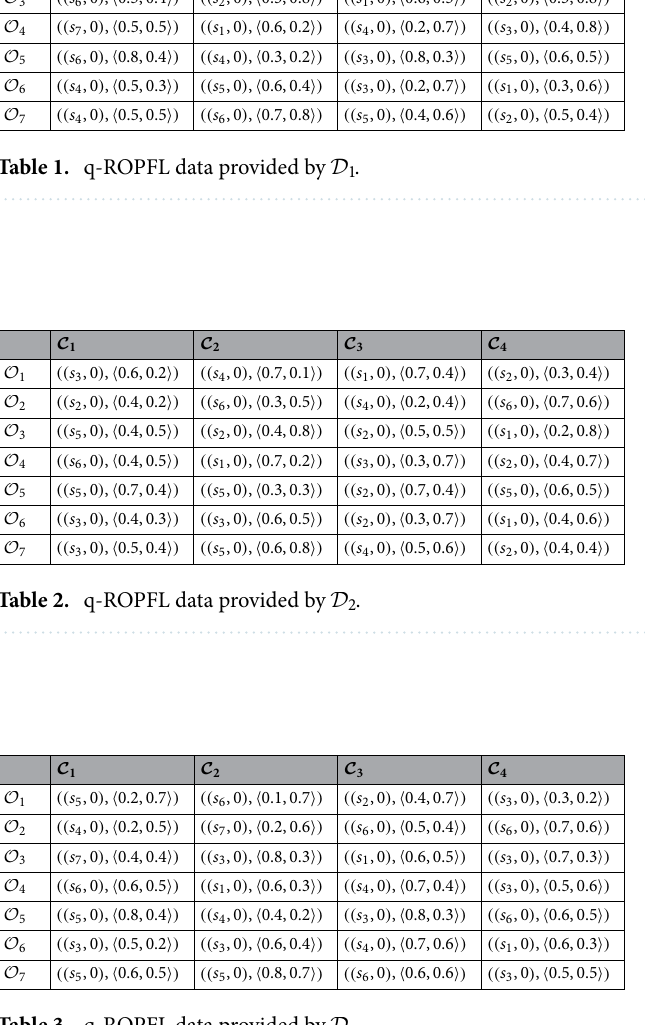
Table 3. q-ROPFL data provided by D 3